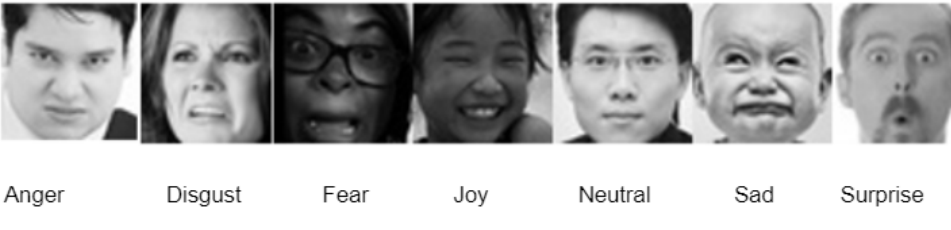
Figure 2. FER-2013